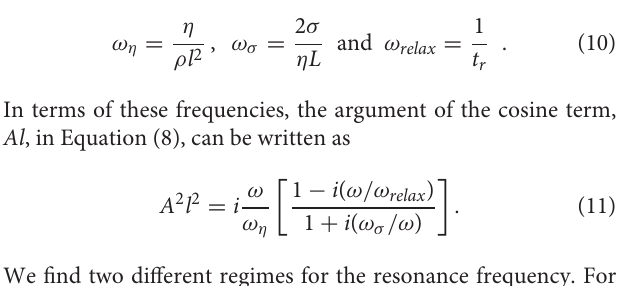
t r , and system’s geometry, l (half the microchannel thickness), as